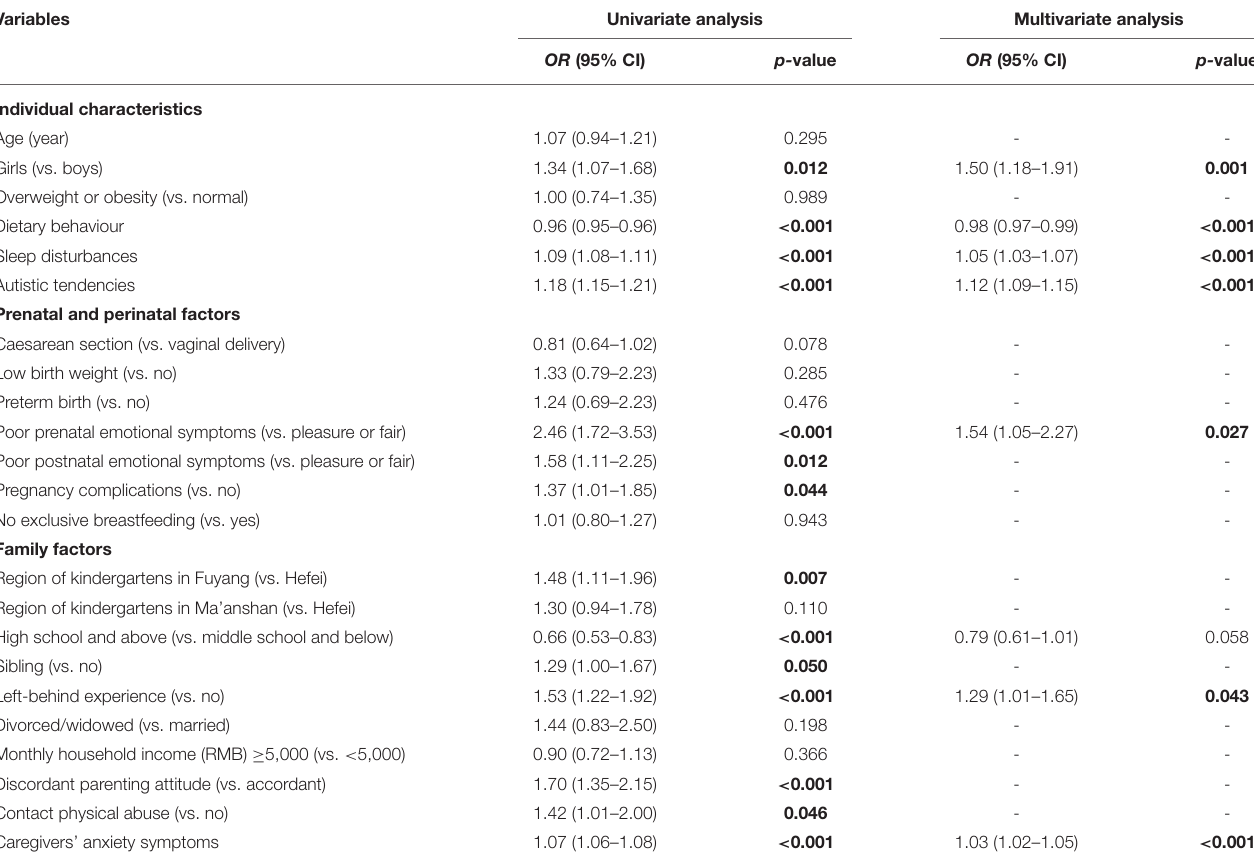
TABLE 3 | Logistic regression models of significant anxiety symptoms and associated factors among preschool